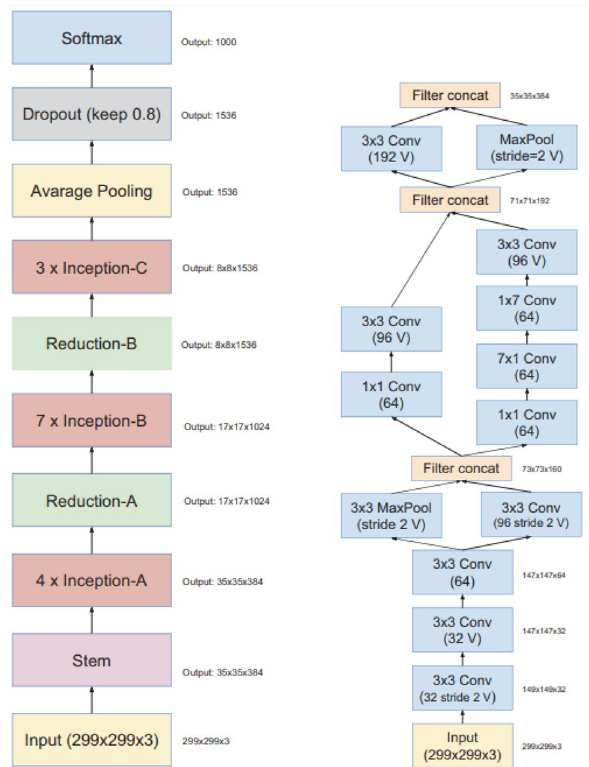
Figure 2. The left side represents the overall schema for the pure Inception Resnet V2, where the right side illustrates the detailed composition of the stem 30 .